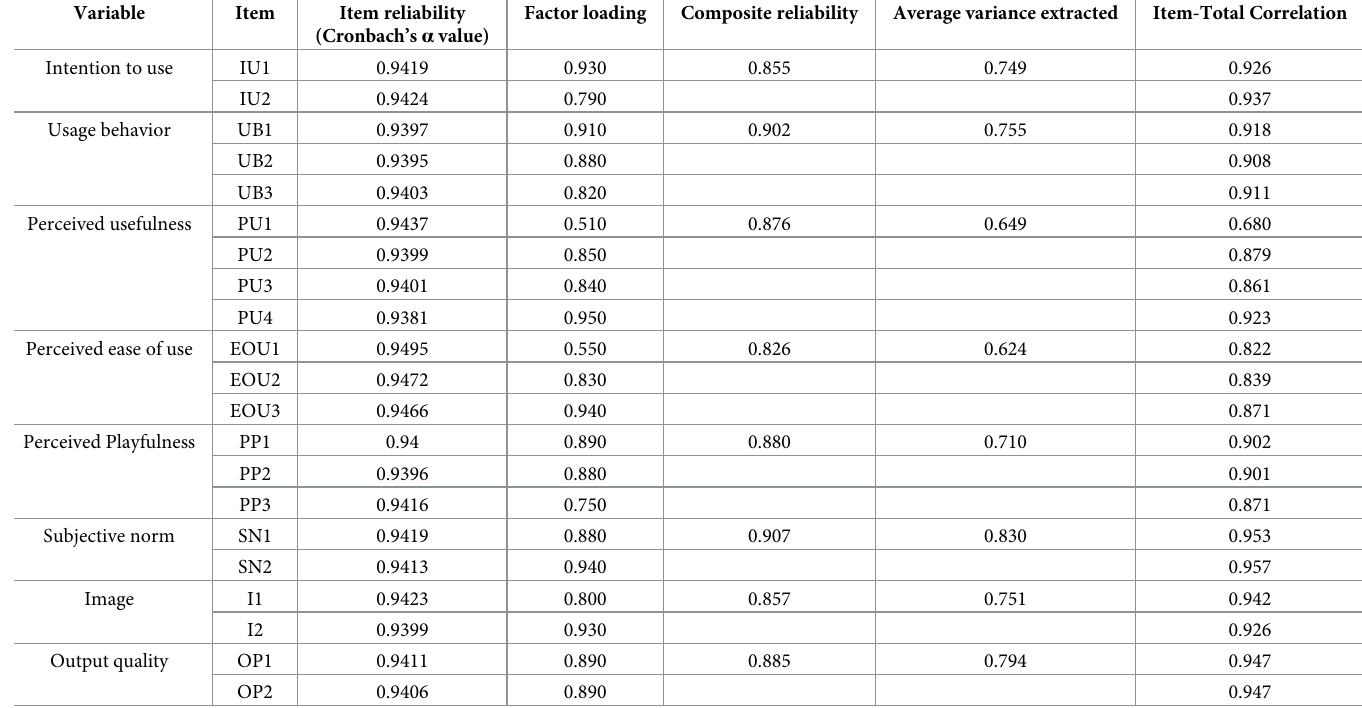
Table 3. Reliability and validity of measurement model for physical